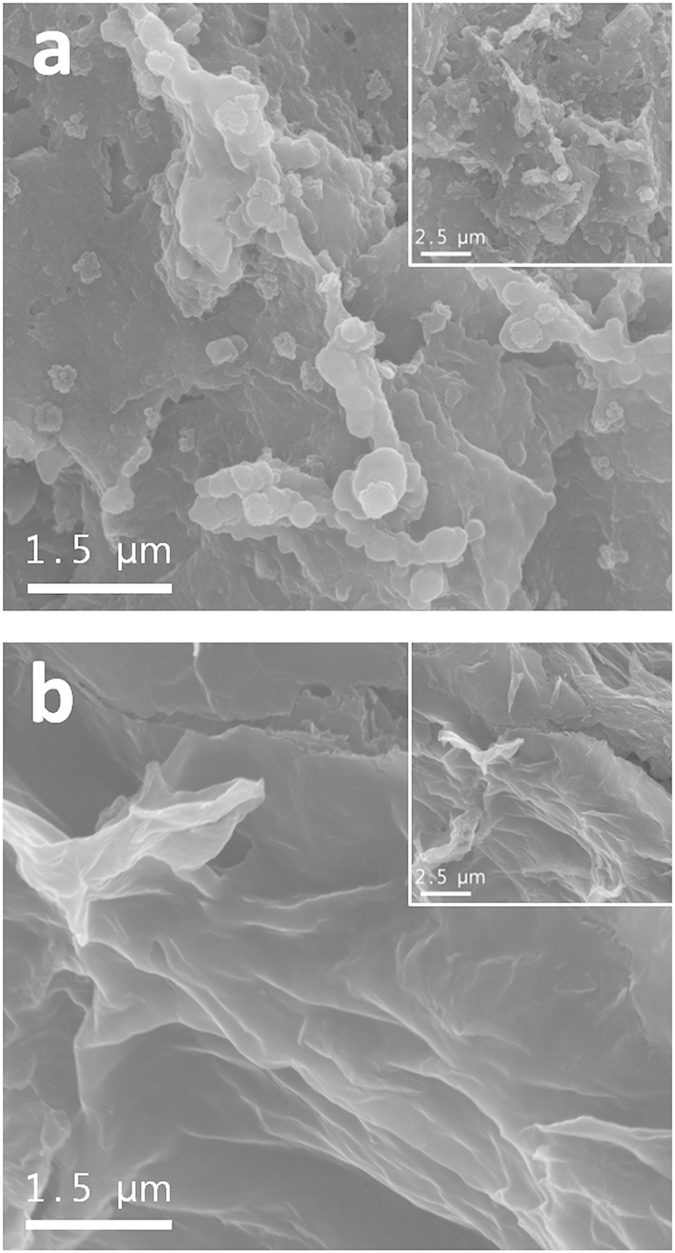
SEM images of (a) pristine electrode and (b) PEDOT electrode after 50th charge.